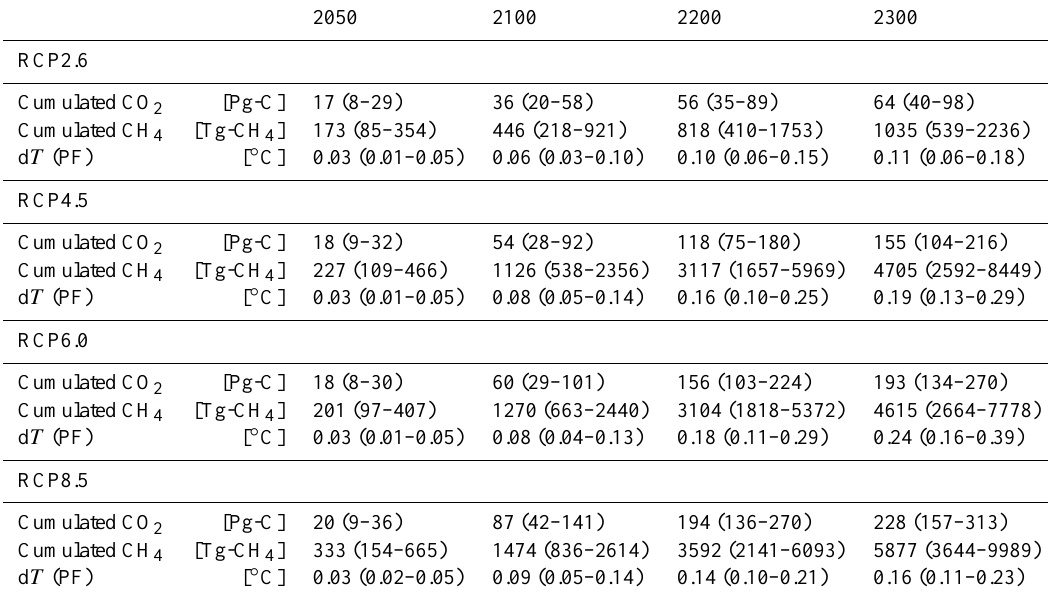
Table 2. Cumulated carbon fluxes and increase in global average surface temperature through newly thawed permafrost in the years 2050, 2100, 2200 and 2300. Median and 68% ranges (in brackets) were calculated from an ensemble of 500 model runs which account for parameter